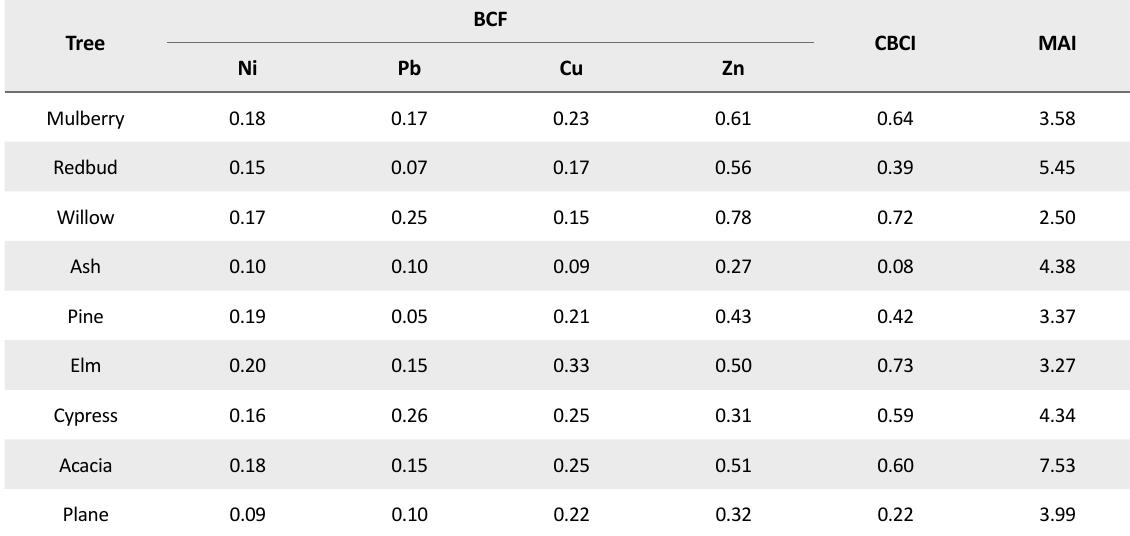
Table 8. Results of Bio-concentration factor (BCF), Comprehensive Bio-concentration index (CBCI), and Metal Accumulation Index (MAI) indices in the leaves of different tree species and soil of the region